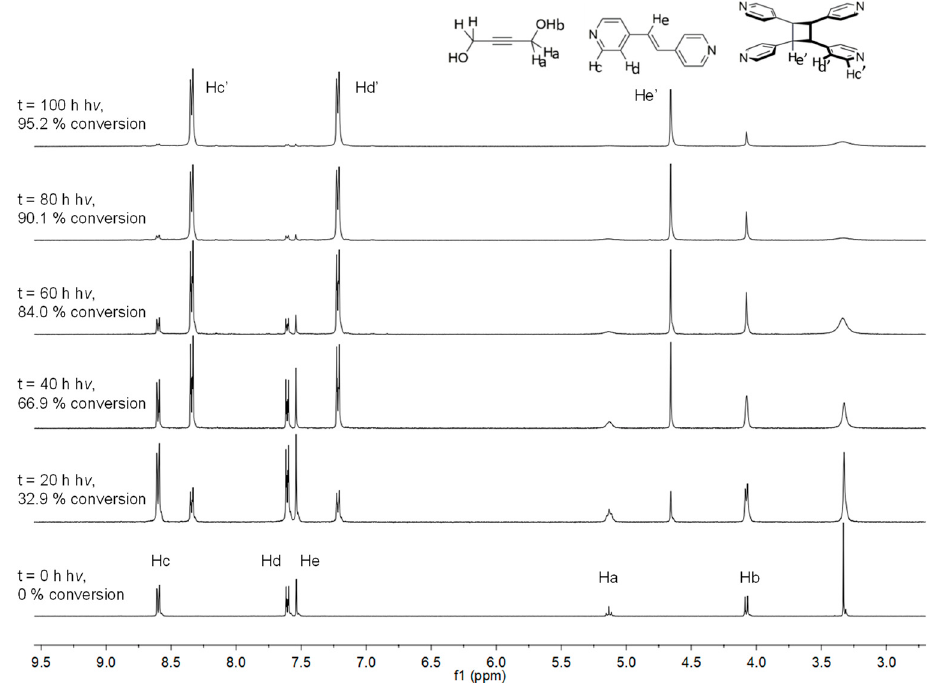
Figure 4. 1 H-NMR spectra (300 MHz, DMSO- d 6 ) monitoring photoreactivity of [( 1,4-bd )·( 4,4’-bpe )] n at 50% catalyst loading of 1,4-bd (100 h UV exposure). UV-exposure time (t) indicated with stacked